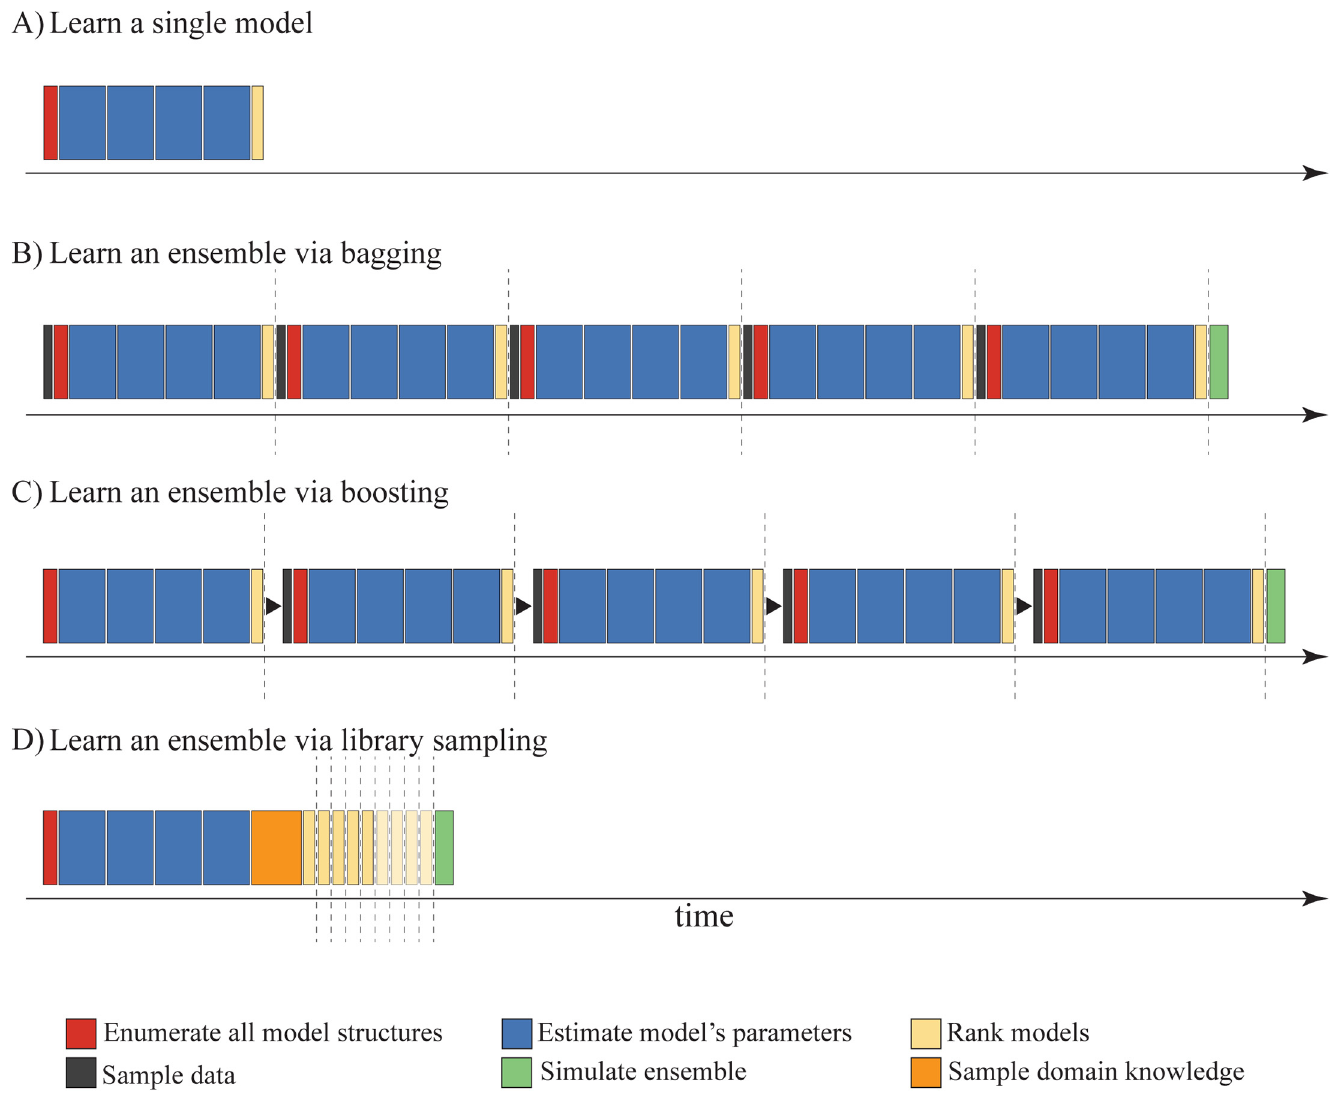
Fig 8. Comparison of the computational complexity of learning a single model and three methods for learning ensembles. A graphical representation of the time complexity of learning a (A) single process-based model and ensembles of process-based models with five constituents with (B) bagging, (C) boosting and (D) library sampling, using the library presented in Table